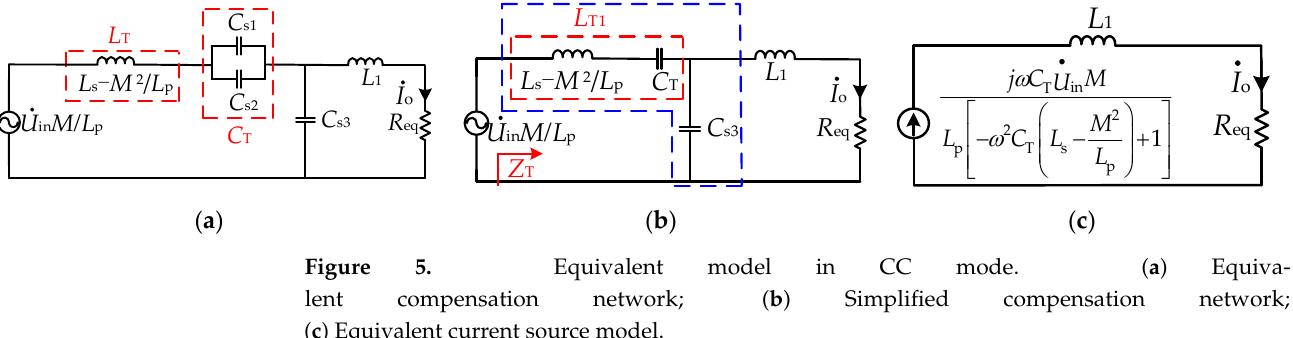
• is • o U U o is the